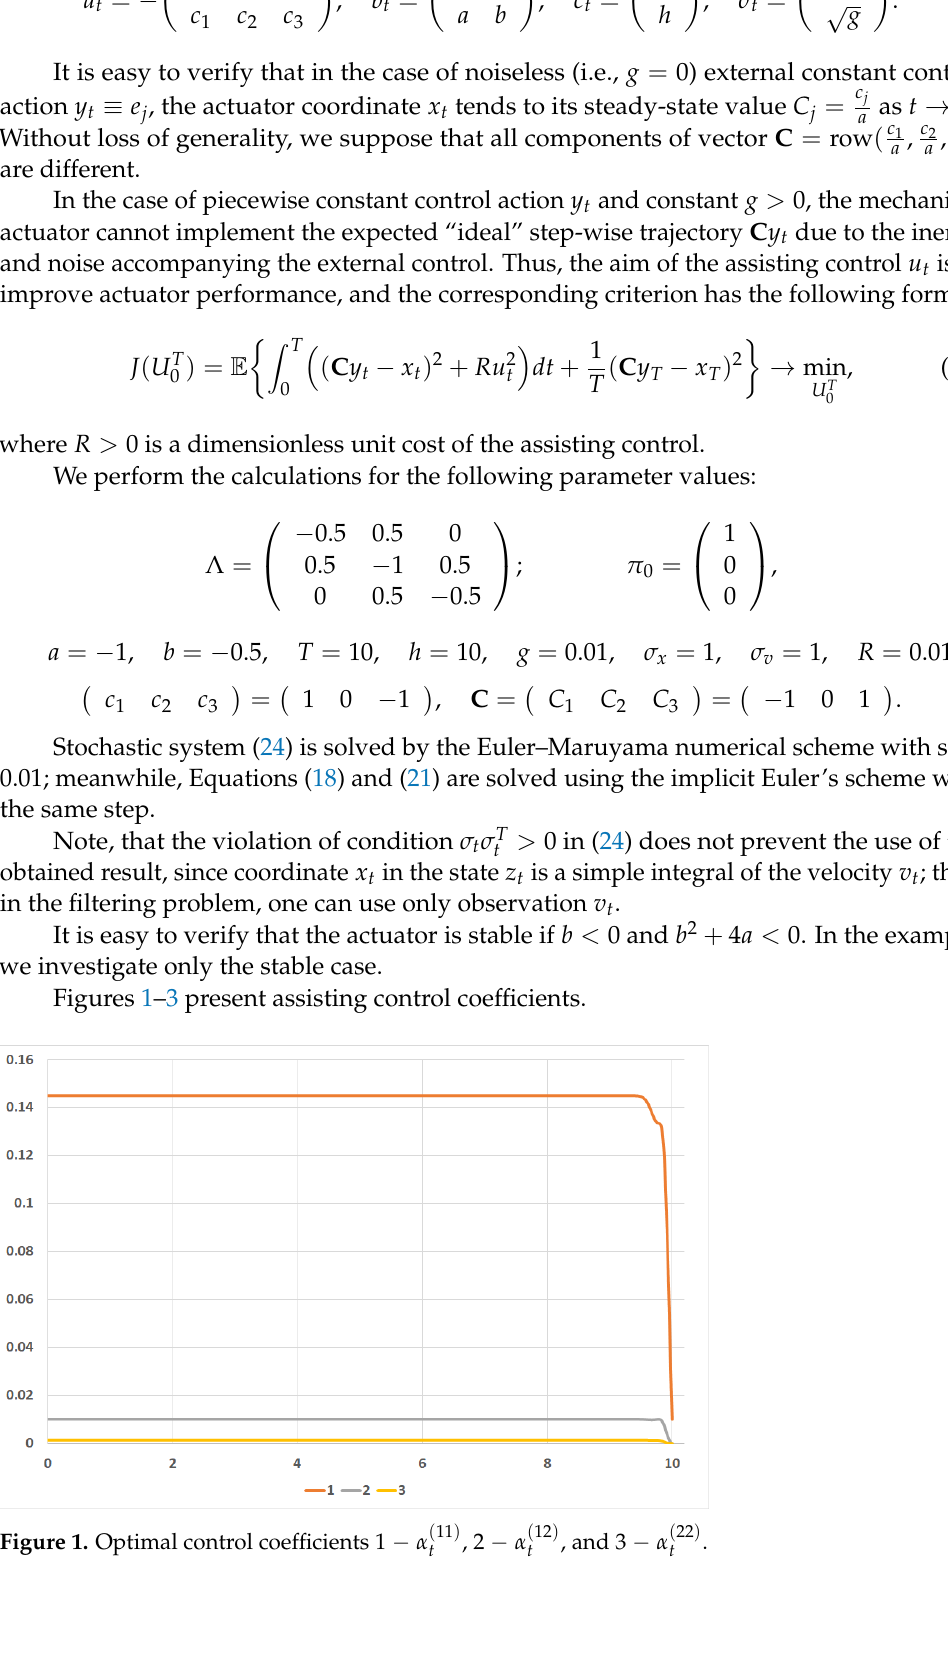
( 12 ) ( 11 ) , 2 − α , and 3 − α t t